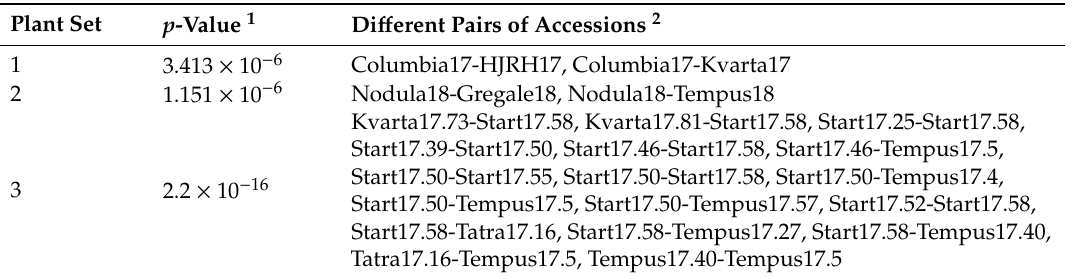
Table 1. Statistically significant differences of nitrogen fixation capacity within three evaluated sets of red clover plants using acetylene reduction assay.